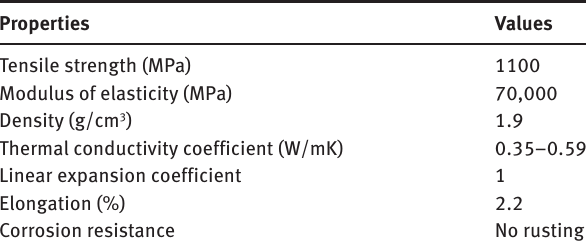
Table 3: Physical, mechanical, and thermal properties of BFRP bar provided by the